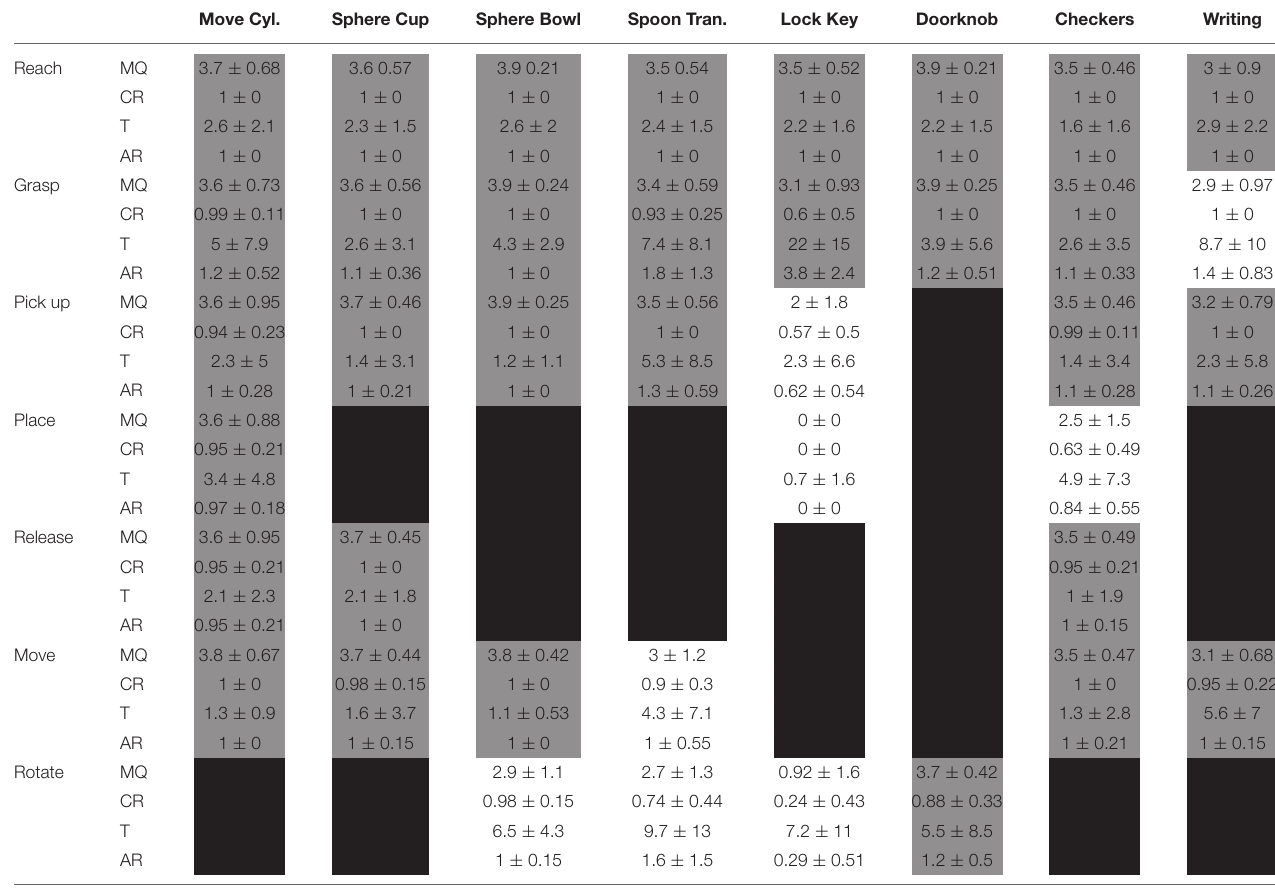
TABLE 8 | Average and standard deviation RW characteristic values across sub-tasks and their high-level tasks. Move Cyl. Sphere Cup Sphere Bowl Spoon Tran. Lock Key Doorknob Checkers